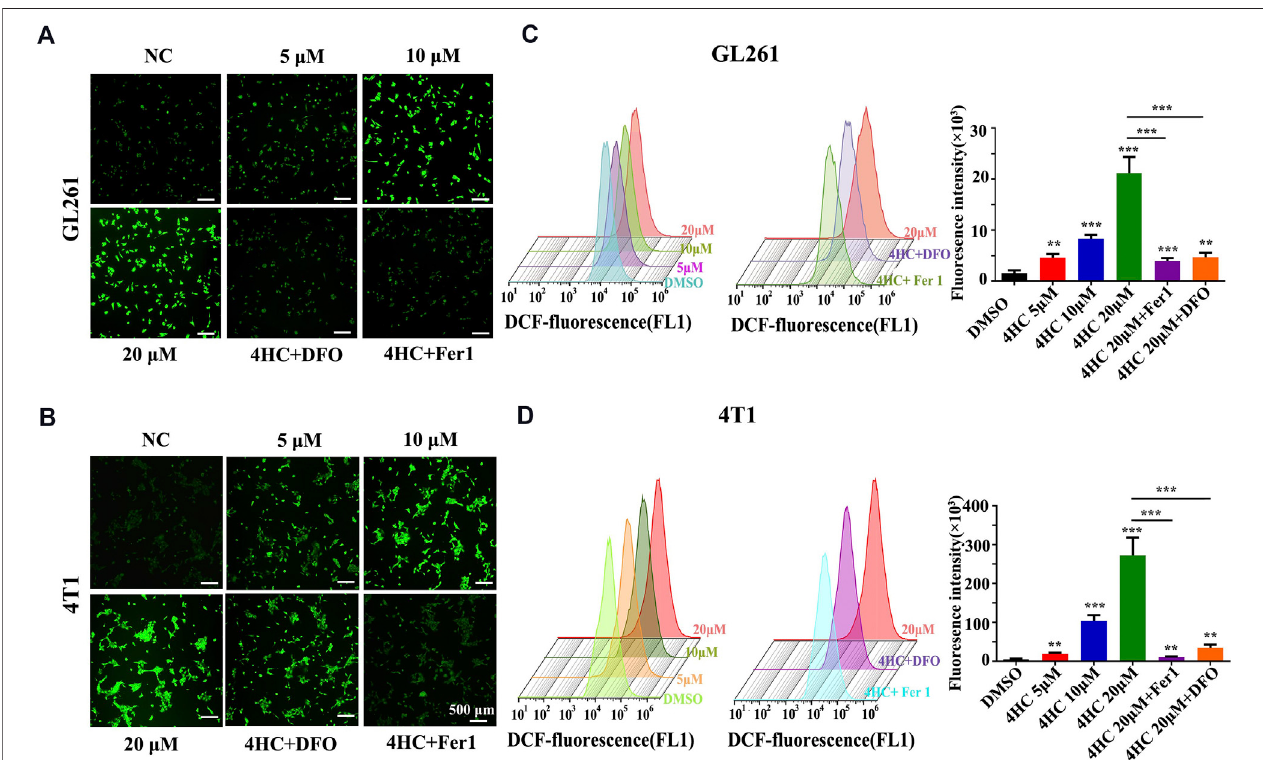
FIGURE 3 | Ferroptosis inhibitors blocked 4HC-induced oxidative stress. Cultured GL261 and 4T1 cells were exposed to 4HC under the indicated conditions. (A – B) Representative images showing ROS levels in tumor cells using DFC. (C – D) Determination and quanti fi cation of the DFC fl uorescence intensity using fl ow cytometry. Values are represented as the means ± SD from more than three independent experiments. ns, not signi fi cant, * p < 0.05, ** p < 0.01, and *** p < 0.001 (one- way ANOVA analysis) for the indicated comparisons.